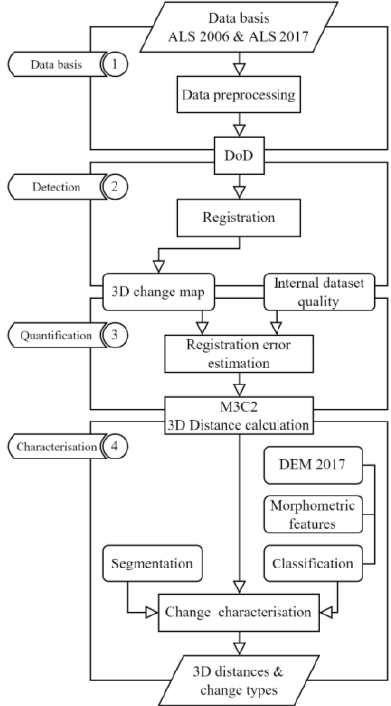
Figure 4 . Change detection and classification workflow with its four sub-processes.